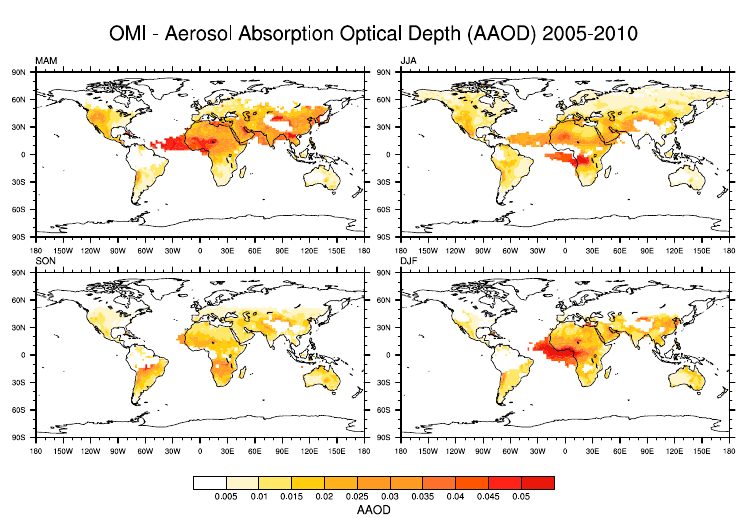
Figure 1. ( Top four panels ) Seasonal average of the absorbing aerosol optical depth (AAOD) distribution at 550 nm from the 8-year average BASE simulation. ( Bottom four panels ) Seasonal average of the absorbing aerosol optical depth distribution from the OMI AAOD satellite product at 500 nm, averaged for 2004 to 2010.